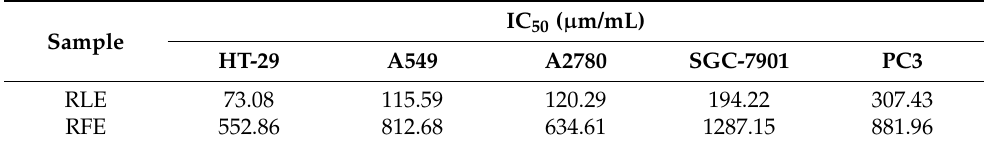
Figure 1. ( A ) Inhibitory effect of RFE and RLE on the growth of five cancer cells at 200 µ g/mL for 48 h (‘x ± SD, n = 3); ( B ) Inhibitory effect of RLE on HT-29 cells (‘x ± SD, n = 3). Table 1. The IC 50 value of RLE and RFE on five kinds of cytotoxicity.